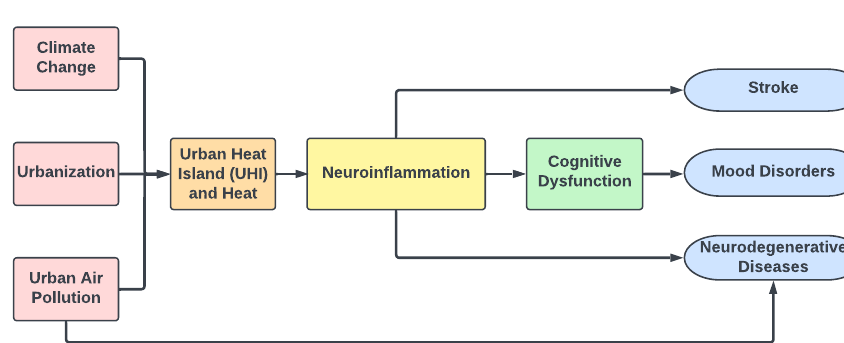
Fig. 3 Potential pathways linking climate change, urbanization, and urban air pollution to neuropathological